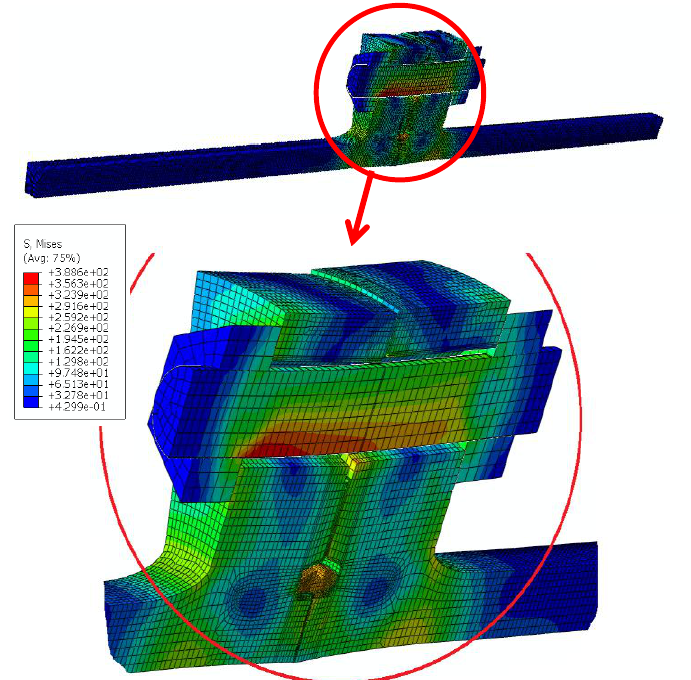
Figure 14. Example of a finite element simulation of creep stress distribution in a 9Cr-1Mo steel pipe connected to an Inconel X625 flange under thermo-mechanical loading. The operating temperature is 575 °C, and the internal pressure is 17